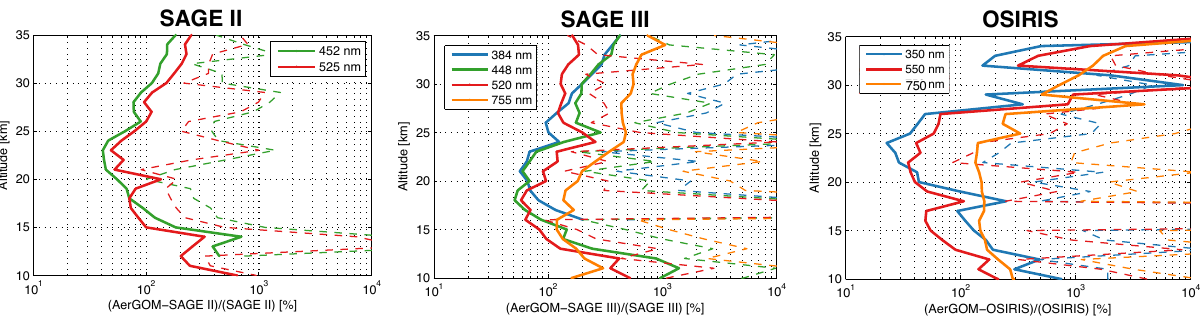
Figure 4. Standard deviation of the aerosol extinction relative difference for AerGOM (solid) and IPF (dashed) comparisons with SAGE II, SAGE III and OSIRIS. Note that the abscissa is scaled